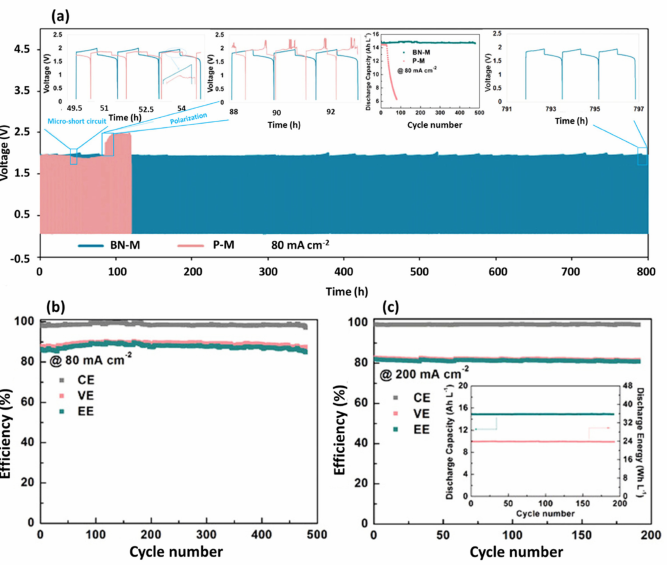
Figure 4. ( a ) Voltage-time profiles of the alkaline zinc-iron flow batteries using BN modified mem- brane and pristine membrane at a current density of 80 mAcm − 2 . Cycling performance of the alkaline zinc-iron flow battery assembled with BN-M at the current density of ( b ) 80 mAcm − 2 ( c ) 200 mAcm − 2 . Inset: the corresponding discharge capacity and discharge energy for each cycle [89] (Reprinted with permission from WILEY-VCH, Copyright ©